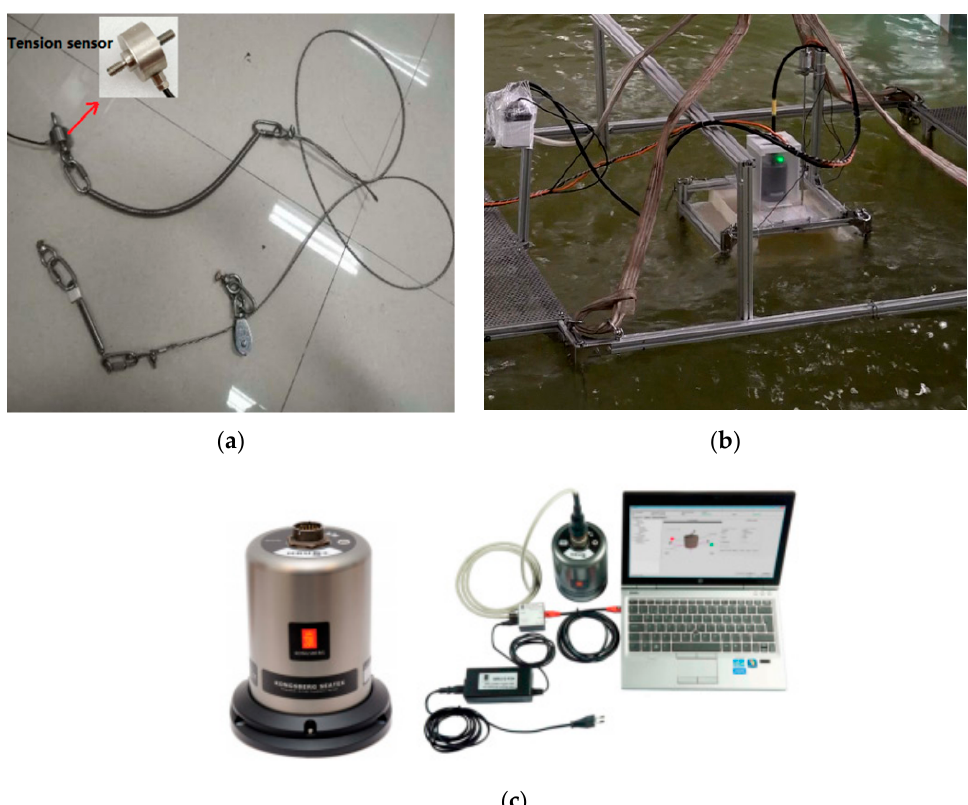
Figure 13. Mooring experiment: ( a ) anchor chains; ( b ) model test; ( c ) 5th generation motion reference unit . Figure 14 shows the angle variations of scheme 1 in the mooring experiment. In the regular wave experiment, the device swings under the impact of regular waves. The maxi- mum pitch angle is approximately equal to 8.9°, and the average value is about 8.08°. The maximum roll angle is approximately equal to 12.2°, and the average value is about 11.28°. The maximum yaw angle is approximately equal to 20.3°, and the average value is about 19.99°.